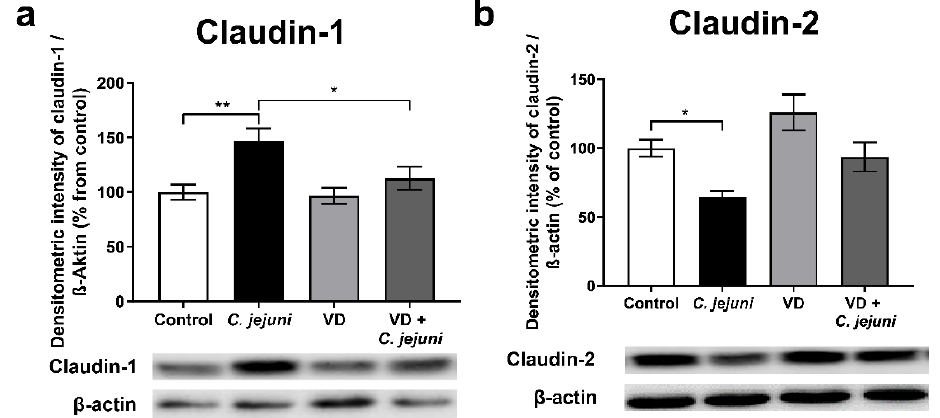
Figure 4. Tight junction protein expression changes in vitamin D-treated C. jejuni -infected epithelial cells. C. jejuni -infected HT-29/B6-GR/MR cells were treated with 200 nM vitamin D. Cells were lysed 48 h after infection and changes in ( a ) claudin-1 and ( b ) claudin-2 determined by Western blot analysis and normalized to β -actin (* p < 0.05, ** p < 0.01, one-way ANOVA with Bonferroni correction, n =